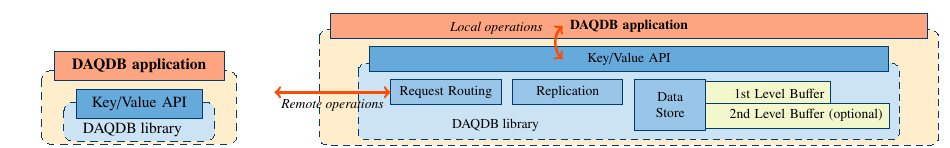
Figure 1. Single-node Figure 2. High-level design of DAQDB application.